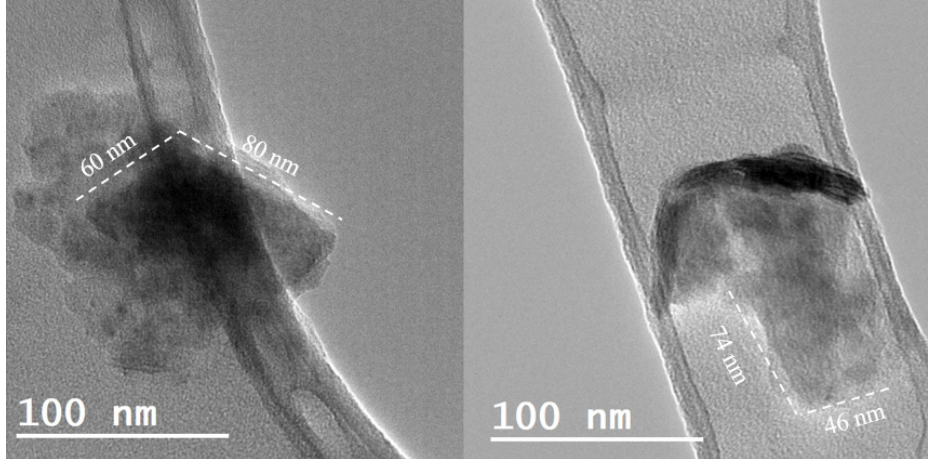
Figure 1. Transmission electron microscopy (TEM) images of the WS 2 nanosheets found in nanofluids prepared by liquid phase exfoliation (LPE).